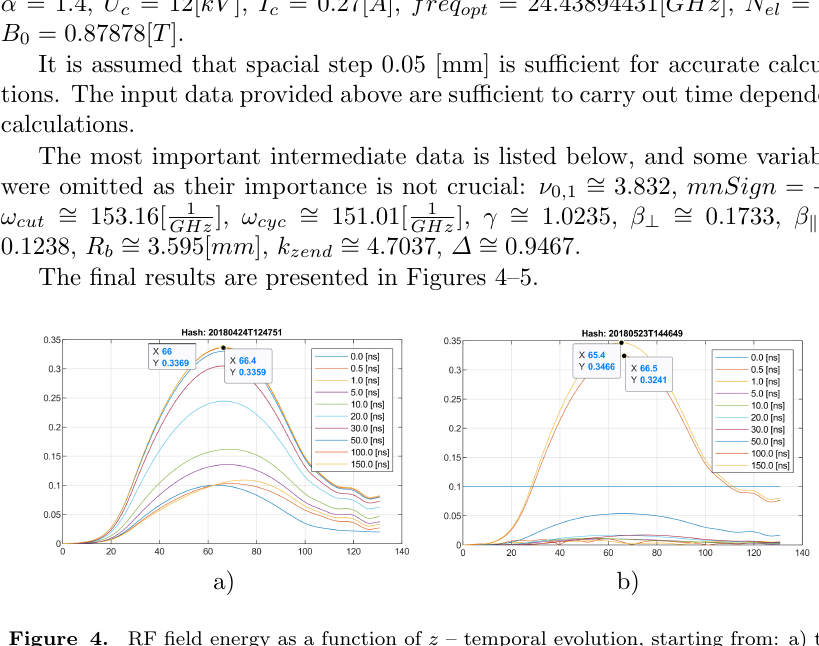
Figure 4. RF field energy as a function of z – temporal evolution, starting from: a) the cold cavity field, b) white noise. The RF field temporal evolution shown in Figure 4 a was obtained from the cold cavity approximation for the initial RF field value. Similar results, obtained by using white noise as the initial condition, are shown in Figure 4 b